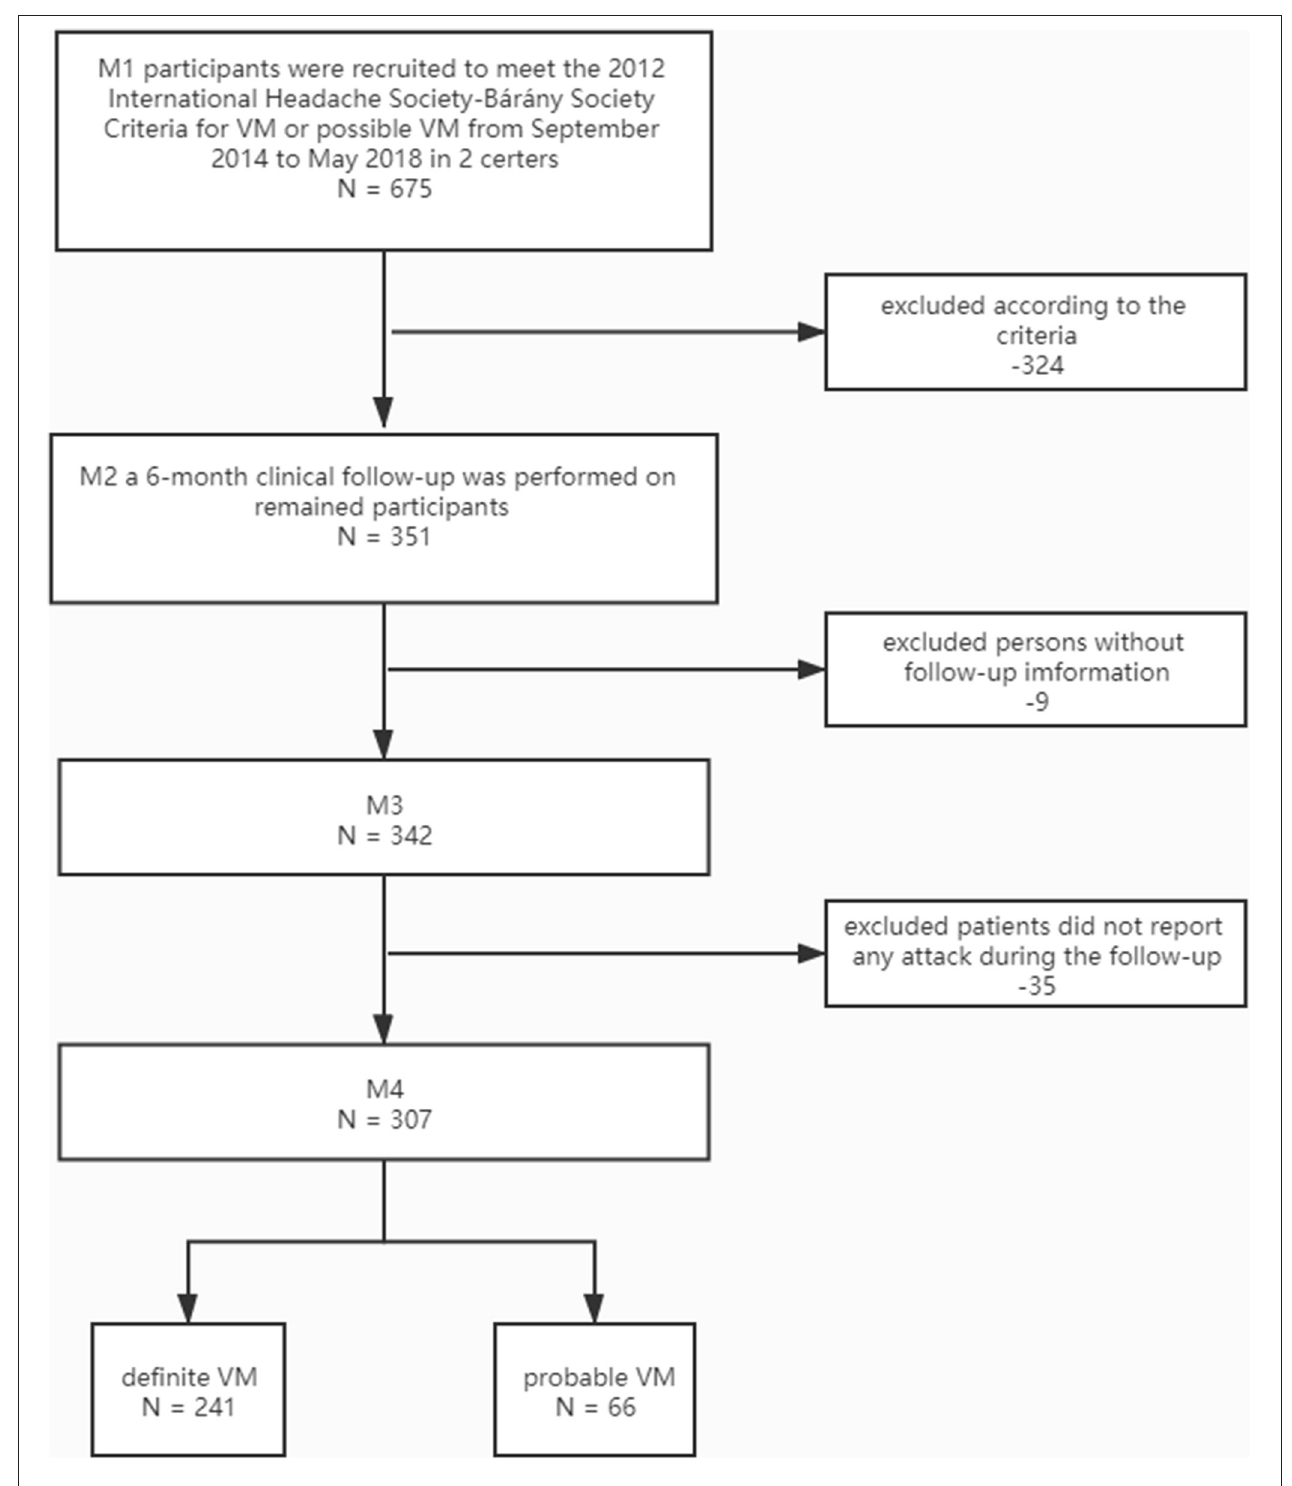
FIGURE 1 | Flow diagram of participants’